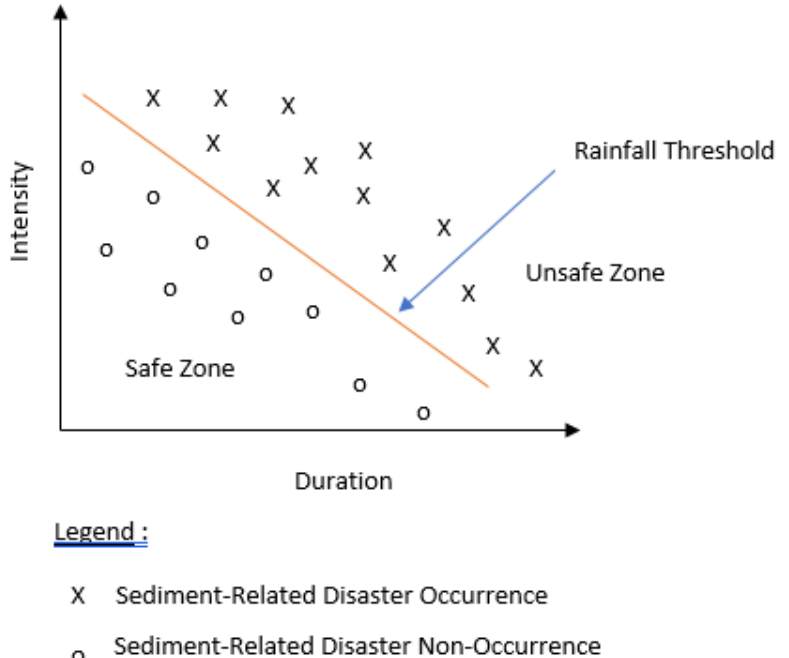
Figure 2. Conceptual description of intensity–duration of rainfall threshold under ideal conditions [24].